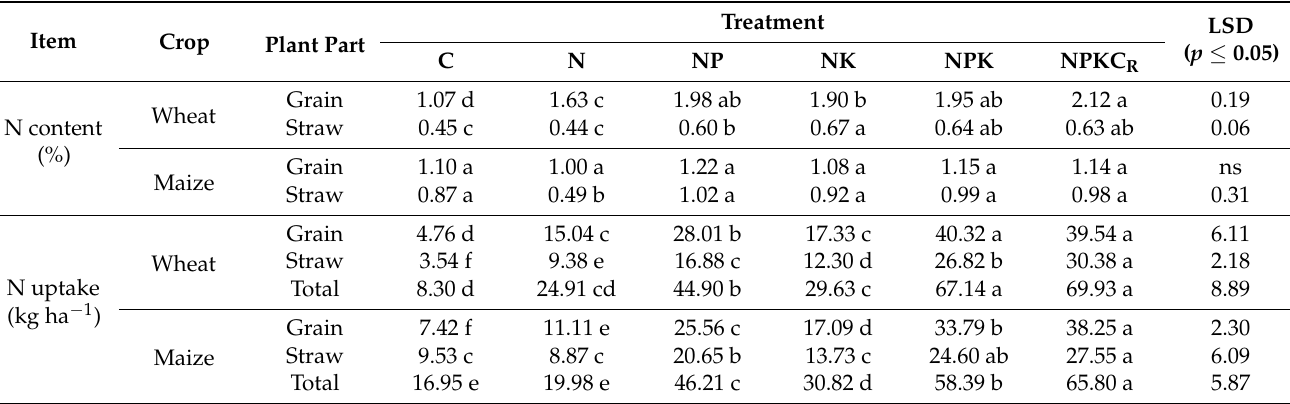
Table 3. Average N content and uptake at maturity in response to different fertilization treatments before liming (over 1991–2010).